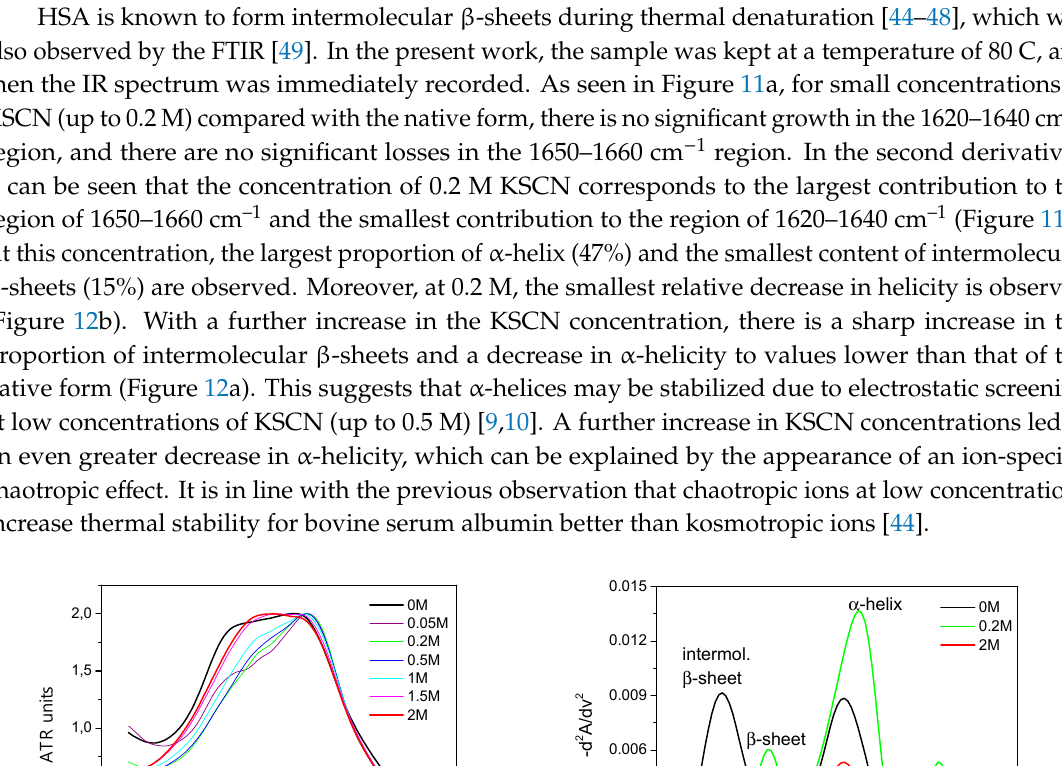
Figure 10. Changes in the character of the Amide I band ( a ) of trypsin at 23 °C with various concentrations of (NH 4 ) 2 SO 4 and ammonium sulfate-induced conformational transition of trypsin at 23 °C ( b ). Protein concentration was 20% wt.